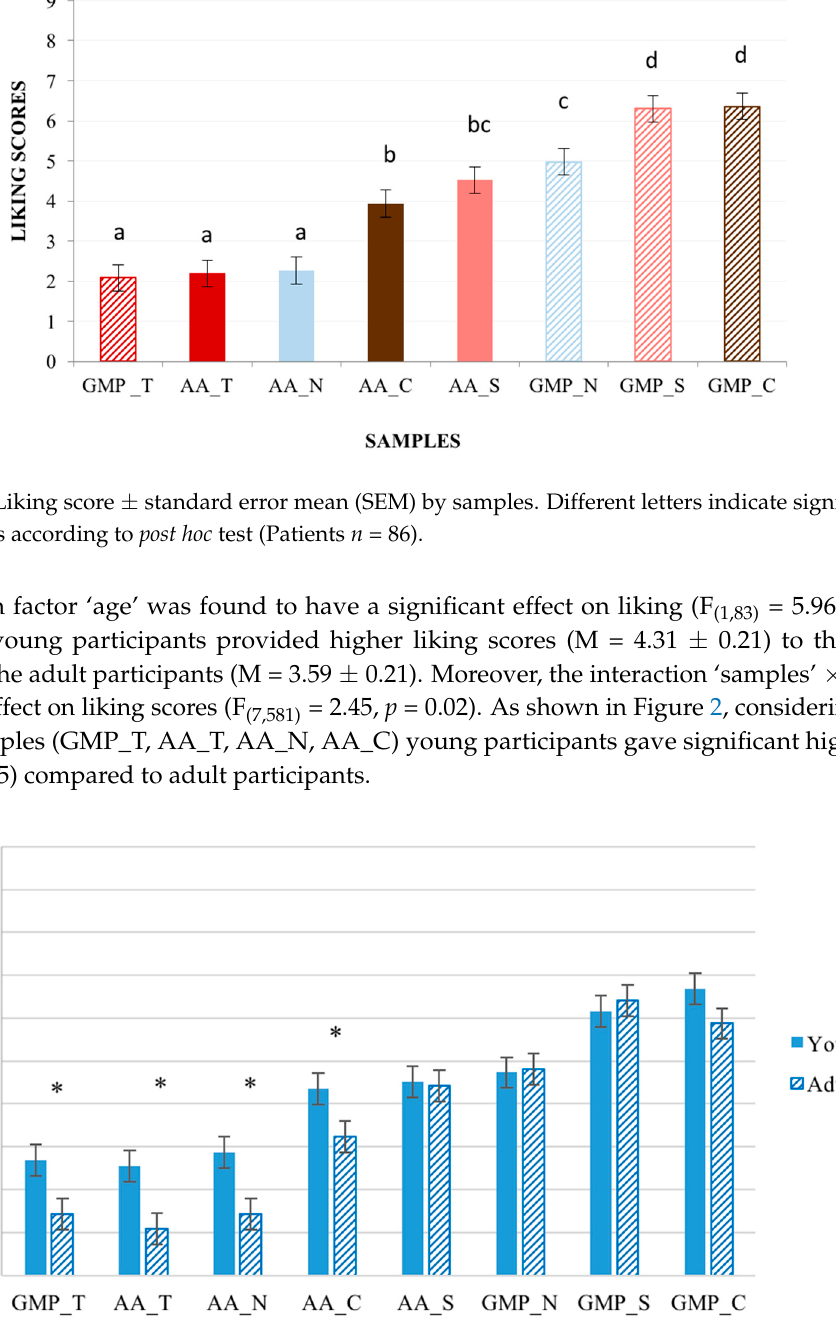
Figure 3. Liking score ± SEM by ‘adherence to diet’ × ‘samples category’. Significant difference for * p < 0.05 (Patients with scarce adherence n = 49, Patients with high adherence n = 37). Considering only GMP samples which obtained the higher liking scores (GMP_C and GMP_S) and the L-amino acid samples flavored with the same aroma (AA_C and AA_S) and the ‘adherence to diet’ a significant ‘sample’ effect was found (F (1,256) = 64.83, p < 0.001). As shown in Figure 4 patients characterized by a scarce adherence to diet gave comparable liking scores to GMP samples compared to patients with high adherence to the diet. Contrarily, patients with scarce adherence to diet gave significant ( p < 0.05) lower liking scores to AA samples compared to subjects with high adherence to